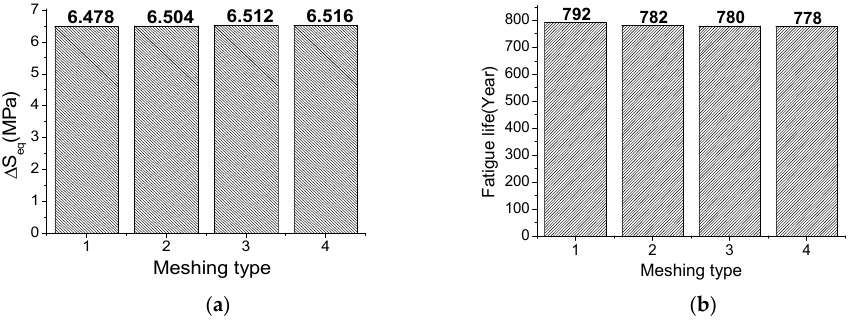
Figure 11. Calculating results using different meshing style: ( a ) ∆(cid:1845) (cid:3032)(cid:3044) ; and ( b ) fatigue life.